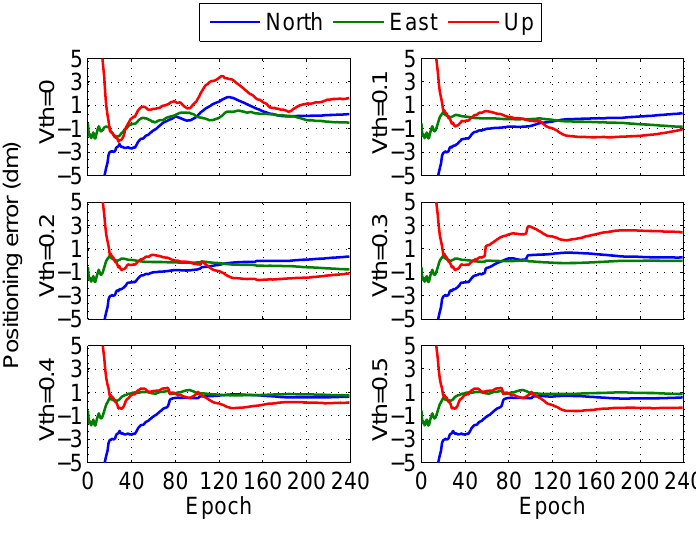
Figure 13. Positioning error of fixed solution in different thresholds at station BSHM in the real-time